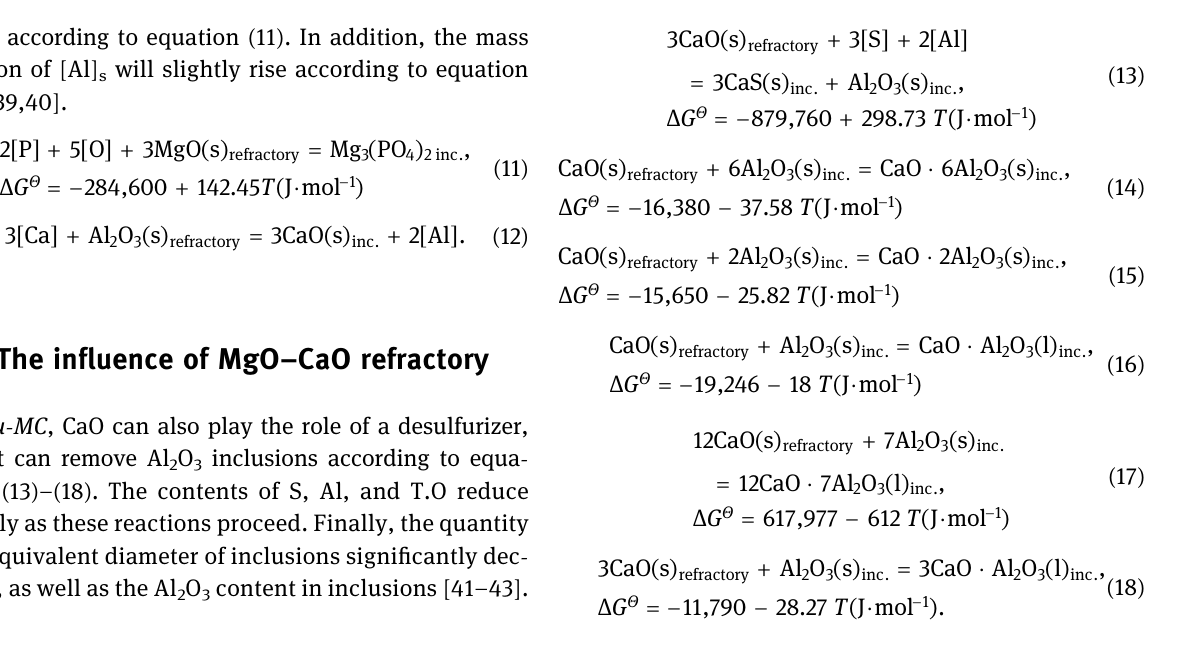
Figure 13: Phase composition of refractories: ( a ) Al 2 O 3 crucible, ( b ) MgO · Al 2 O 3 crucible, and ( c ) and ( d ) MgO · CaO